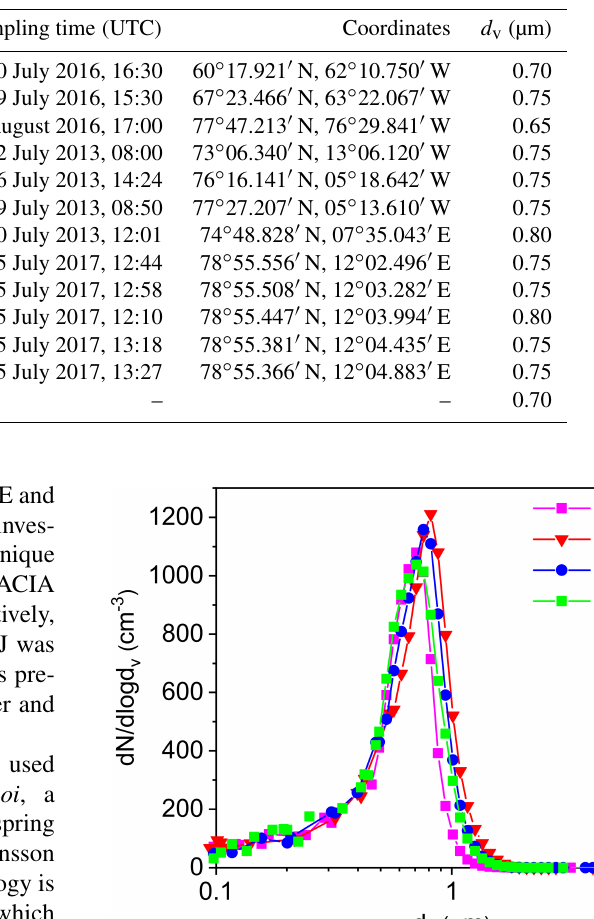
Table 2. Overview of the investigated samples, specifying the sampling location, sampling time, and coordinates. The last column denotes the median equal-volume sphere diameter, d v , of the particles that were generated by nebulising the bulk solutions and then injected into the AIDA chamber for the ice nucleation experiments.